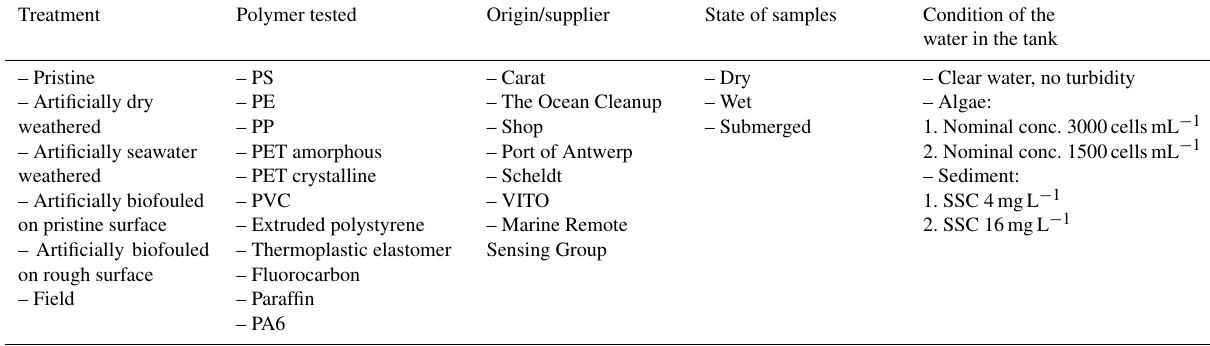
Table 4. Overview of the polymer and treatment performed during the study (SSC: suspended sediment